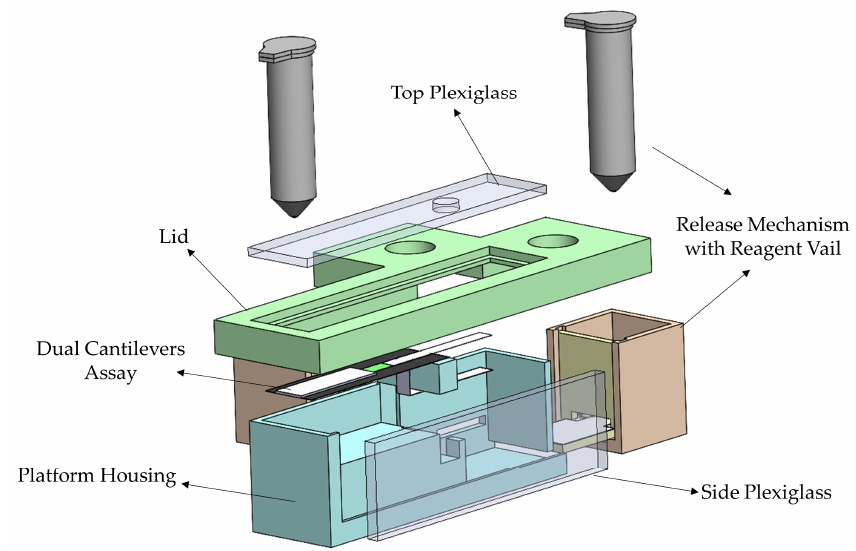
Figure 4. An exploded view of the proposed platform.